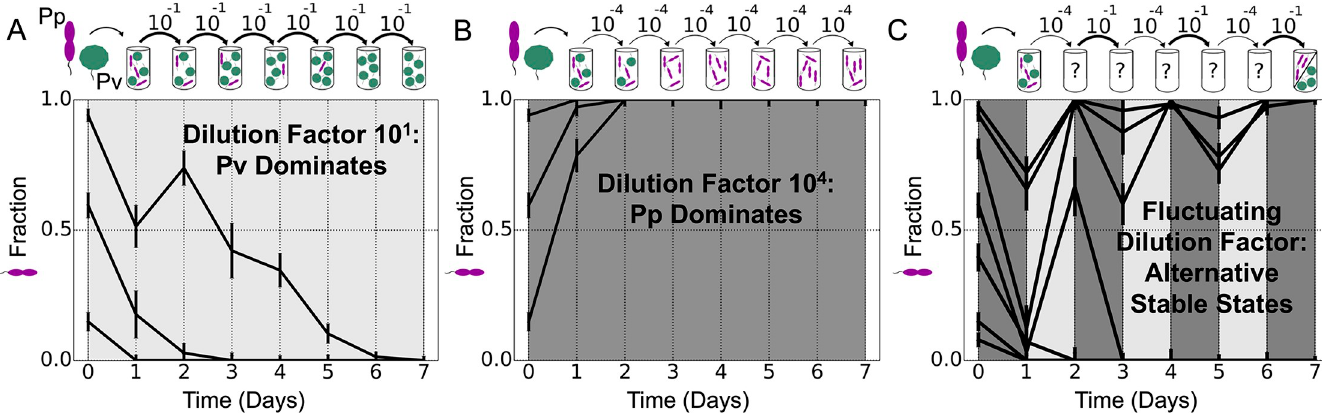
Fig 1. Experimental observation of alternative stable states in a fluctuating environment. A : When a coculture of Pp (purple) and Pv (green) was diluted by a factor of 10 each day (1/10 of the previous day’s culture transferred to fresh media, keeping the volume constant), the slow-growing Pv dominated, sending the fraction of fast grower Pp to zero from several starting fractions. B : When the same culture was subject to a much higher dilution factor, 10 4 , fast grower Pp dominated. C : Fluctuating between the low and high dilution factors shown in A and B resulted in alternative stable states. Either Pp or Pv can dominate, depending on their relative initial abundances. In all plots, we qualitatively indicate the dilution factor for that day by the shading of the plot; low dilution factors have a lighter shading, while high dilution factors have a darker shading. Error bars are the SD of the beta distribution with Bayes’ prior probability (see Methods).